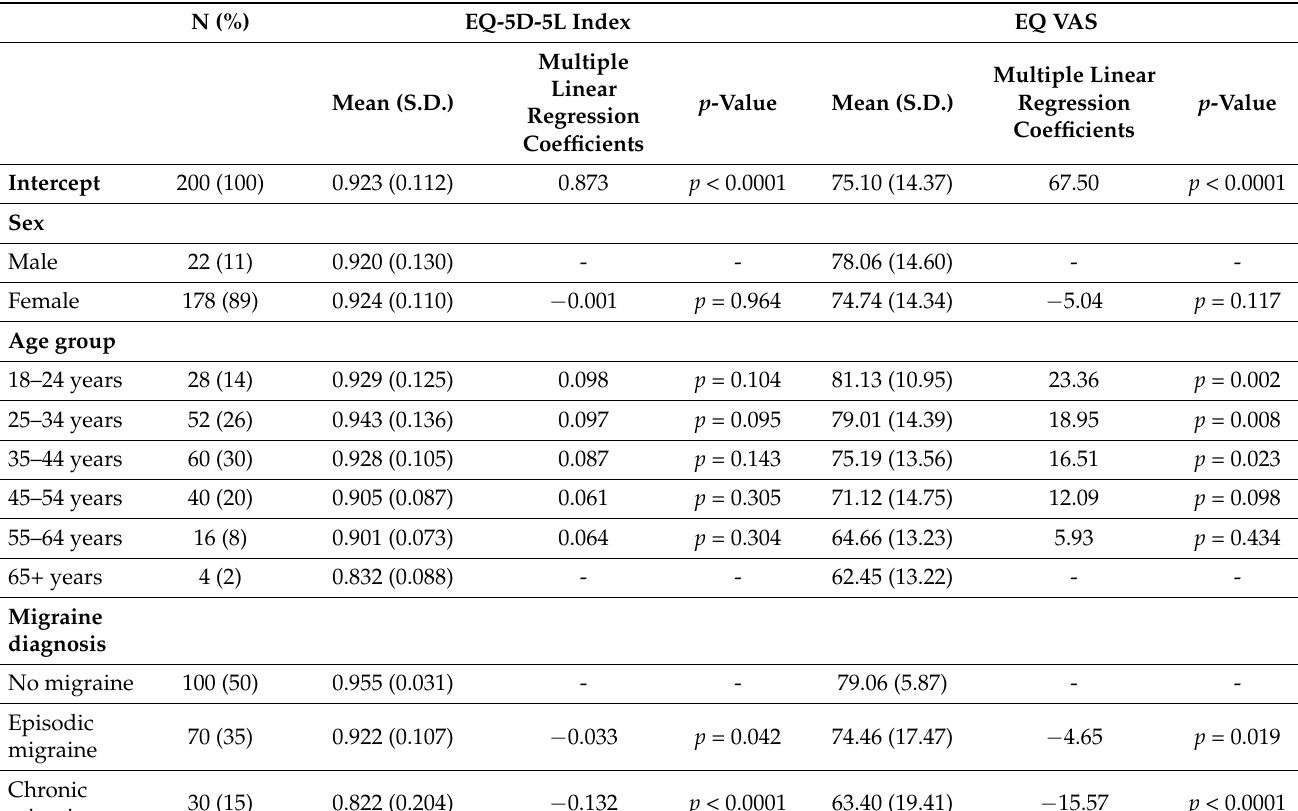
Table 3. Influence of demographic factors and migraine status on HRQoL